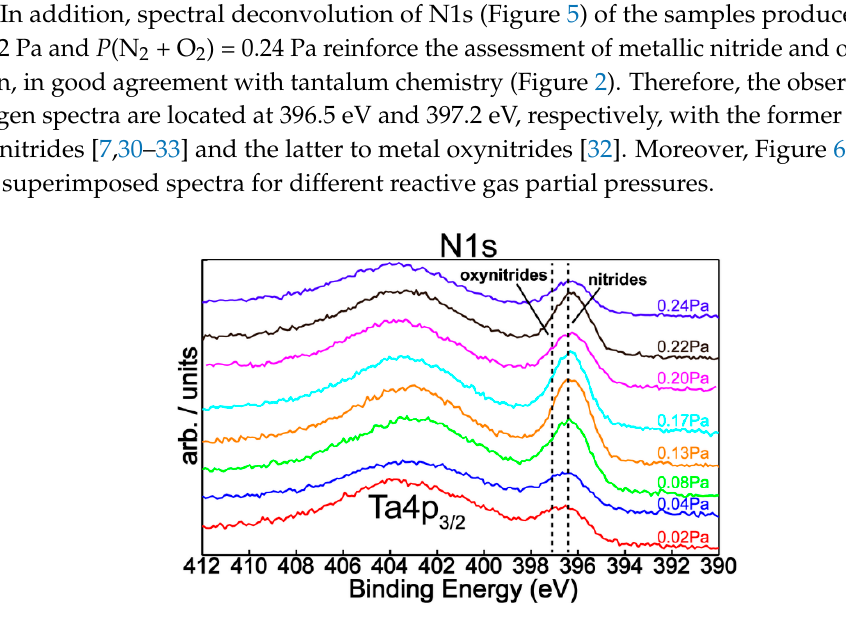
Figure 4. N1s XPS superimposed spectra for different reactive gas partial pressures.